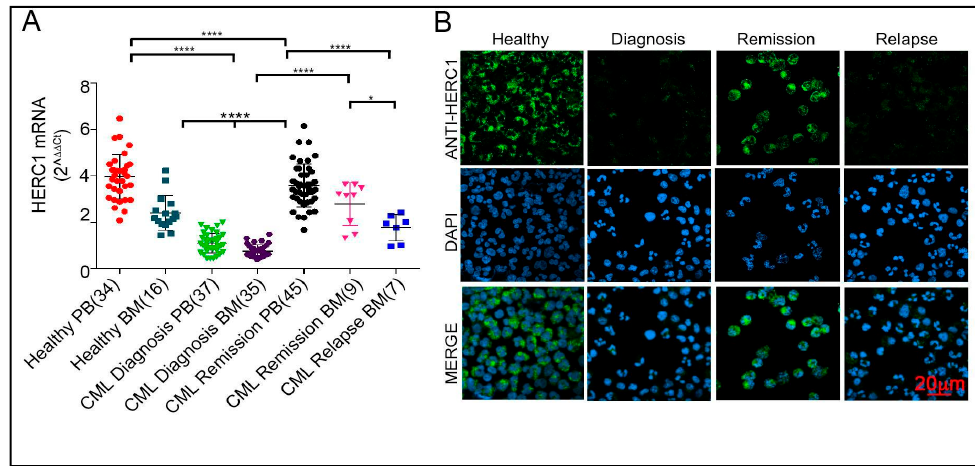
Figure 4. HERC1 gene expression is differently regulated in CML patients during the evolution of the disease. ( A ) HERC1 gene was differentially expressed during the different CML phases being severely down-regulated at diagnosis, both in BM and PB CML specimens, increased at remission and declined again at the onset of relapse. ( B ) Similarly to the mRNA, in primary CML cells the HERC1 protein amount was barely detectable at diagnosis and at the relapse onset. On the contrary, at remission the protein level was comparable to that of healthy control. Immunofluorescence was performed on cytospun cells by using specific rabbit polyclonal anti HERC1 antibody. DAPI staining (blue) indicated the cell’s nuclei. The green signal corresponds to the HERC1 protein. * p < 0.05, **** p < 0.0001.